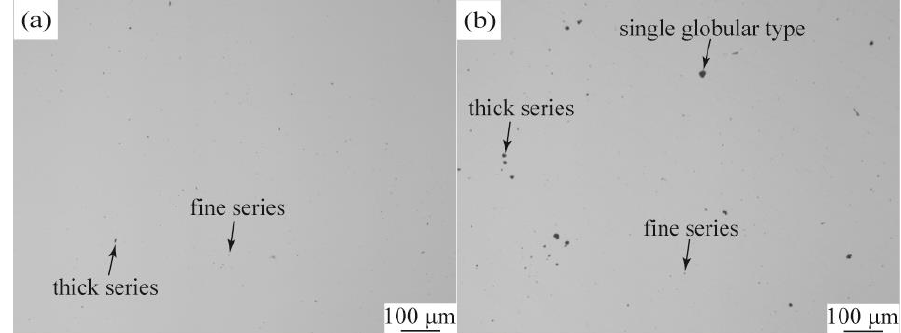
Figure 6. Stress-strain curves ( a ) of the steels after quenching and tempering at different temperatures and mechanical properties, ( b ) strength, ( c ) plasticity and ( d ) impact energy together with hardness. Solid lines and symbols mean the oxide-added steel, and dashed lines and open symbols denote the conventional one.